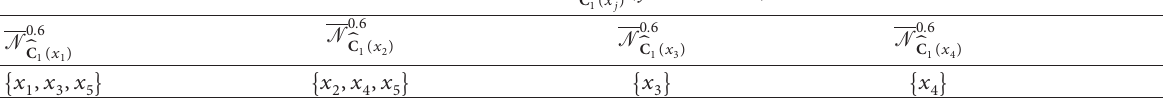
( j � 1 , 2 , ... , 5 ) . C 1 ( x j )